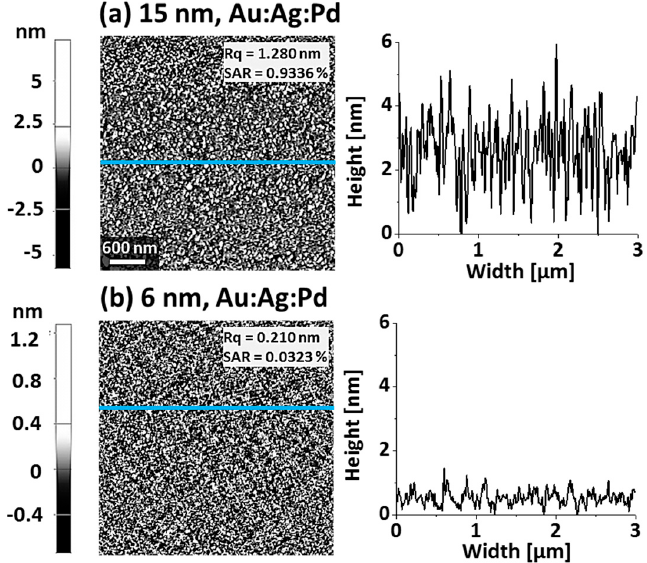
Figure A2. Pre-annealed samples surface morphology after the deposition of Au, Ag, and Pd tri-layer with distinct thickness: ( a ) total thickness of 15 nm with 5 nm of Au, Ag, and Pd in a sequence; ( b ) total thickness of 6 nm with 2 nm of Au, Ag, and Pd in a sequence. The surface morphology depicts higher roughness with 15 nm of thickness, as shown by the cross-sectional line profiles.